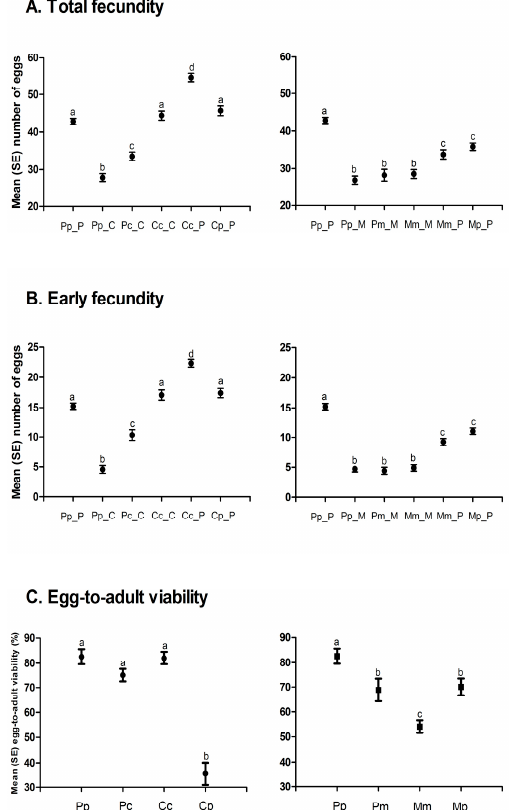
Figure 3. Life history traits (Mean ± SE) during experimentally induced host-shift: ( A ) Total fecundity, ( B ) early fecundity, ( C ) egg-to-adult viability. Different letters indicate statistically significant differences between groups at p < 0.005, Tukey’s Studentized Range (HSD) Test.